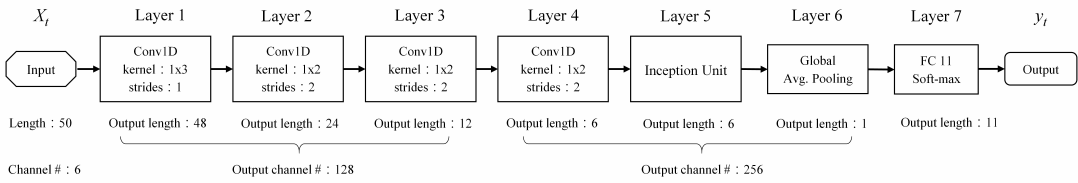
Figure 7. The parameters of the PairNet with Inception. The input X t has the same dimension and number of channels as those of the input of PairNet. The network contains seven layers, where layers 1–4 are convolution layers. The inception module is located at layer 5. The architecture of inception module is revealed in Figure 8. Layer 6 is the average pooling layer. The number of gestures to be classified is Q = 11. Layer 7 is a fully connected layer producing 11